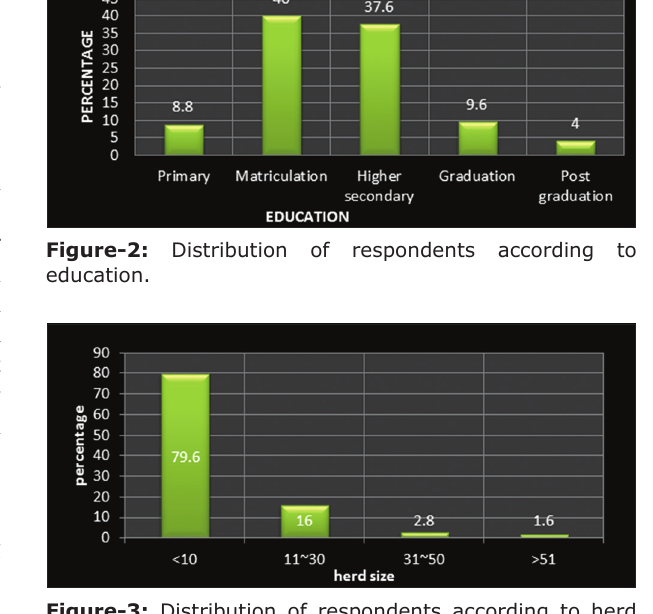
Figure-3: Distribution of respondents according to herd size. Table-1: Exposure of livestock farmers to risk factors associated with various types of farm activities and eating habits.